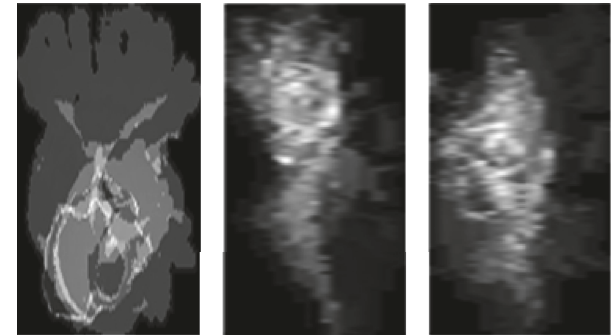
Figure 3: Three DMMs of a depth action sequence “Swipe left” from the front ( 𝑓 ) view, side ( 𝑠 ) view, and top ( 𝑡 ) view,